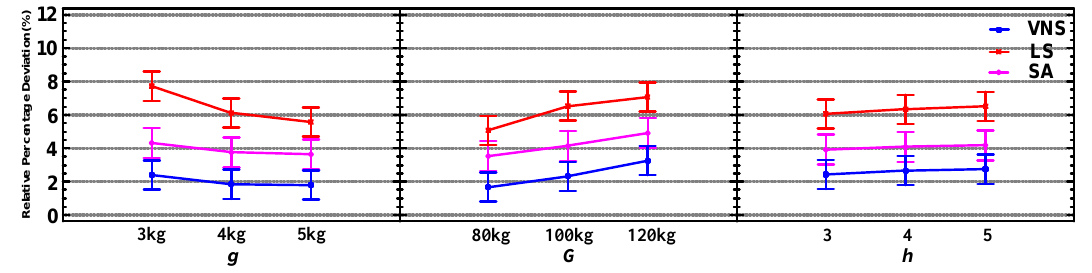
Figure 6. Interactions between g , G and h with 95.0% Tukey HSD intervals.